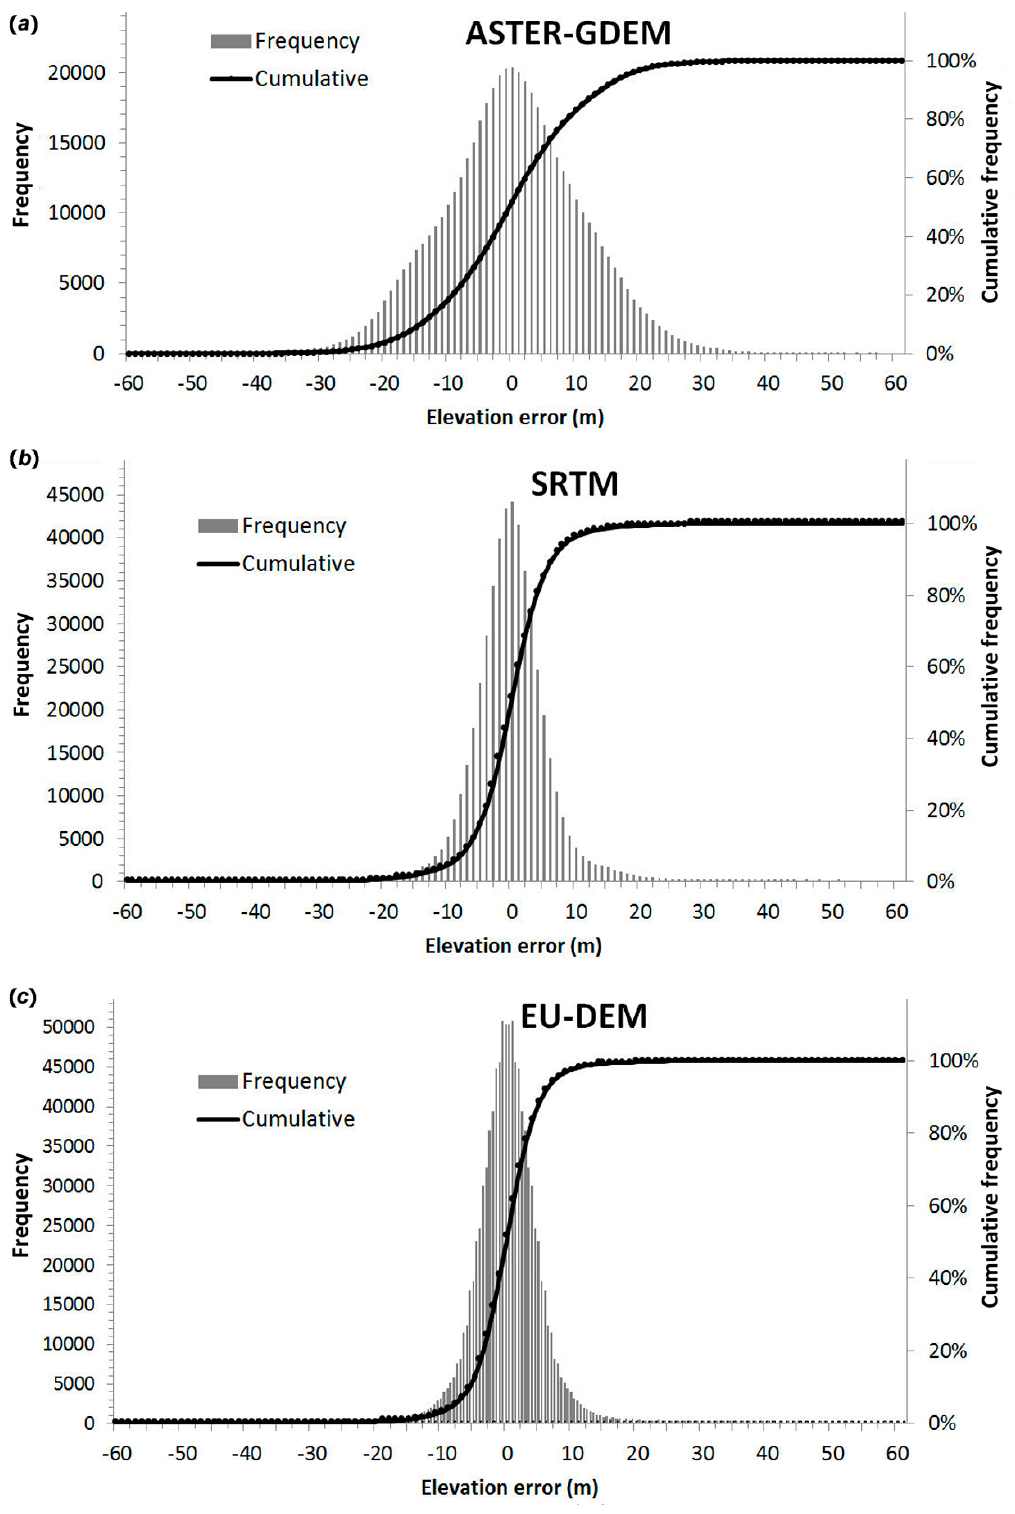
Figure 6. Histograms of relative elevation errors for the three DEMs: ( a ) ASTER-GDEM, ( b ) SRTM DEM, ( c ) EU-DEM.